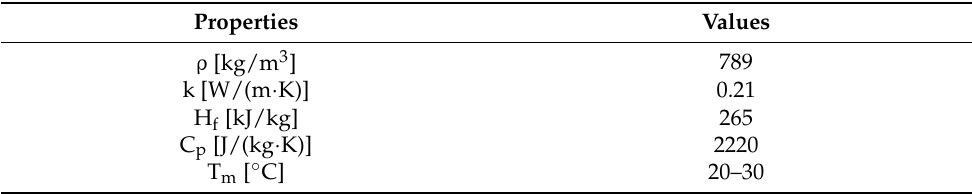
Table 5. Properties of PCM A28 (PlusICE ® ) [29].